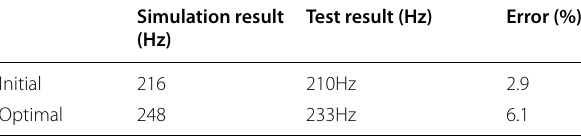
Table 7 First‑order frequency optimization